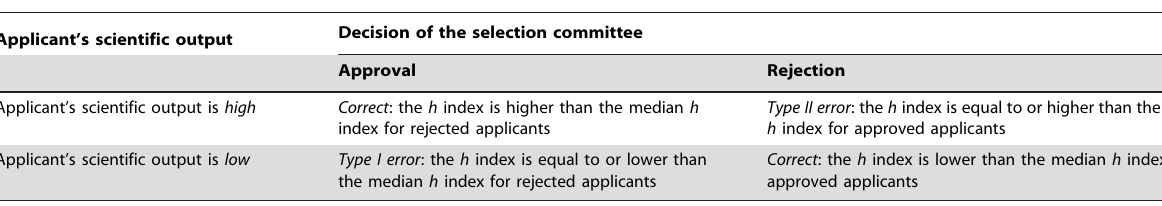
Table 5. Type I and type II errors as well as correct decisions in EMBO peer